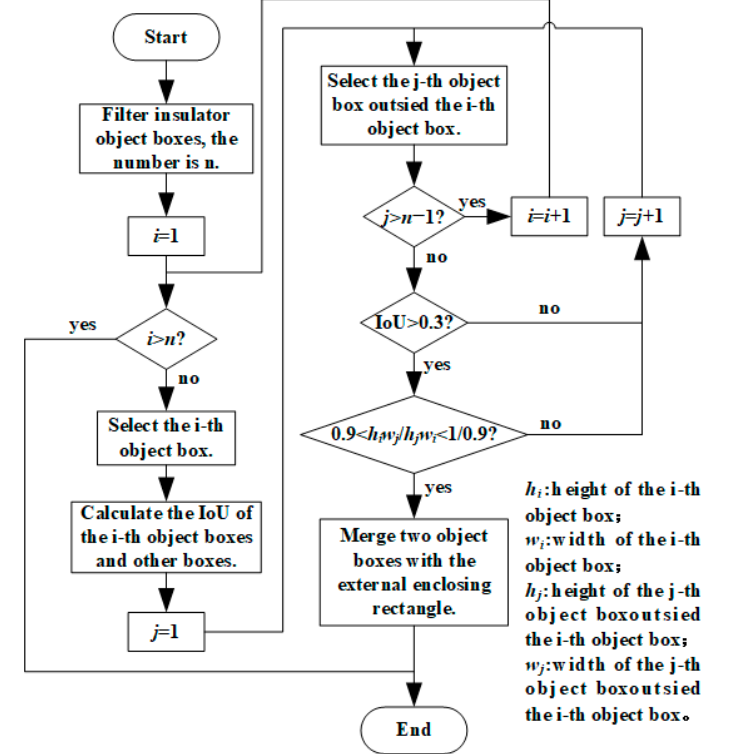
Figure 5. Flowchart of the post-processing of prediction boxes.